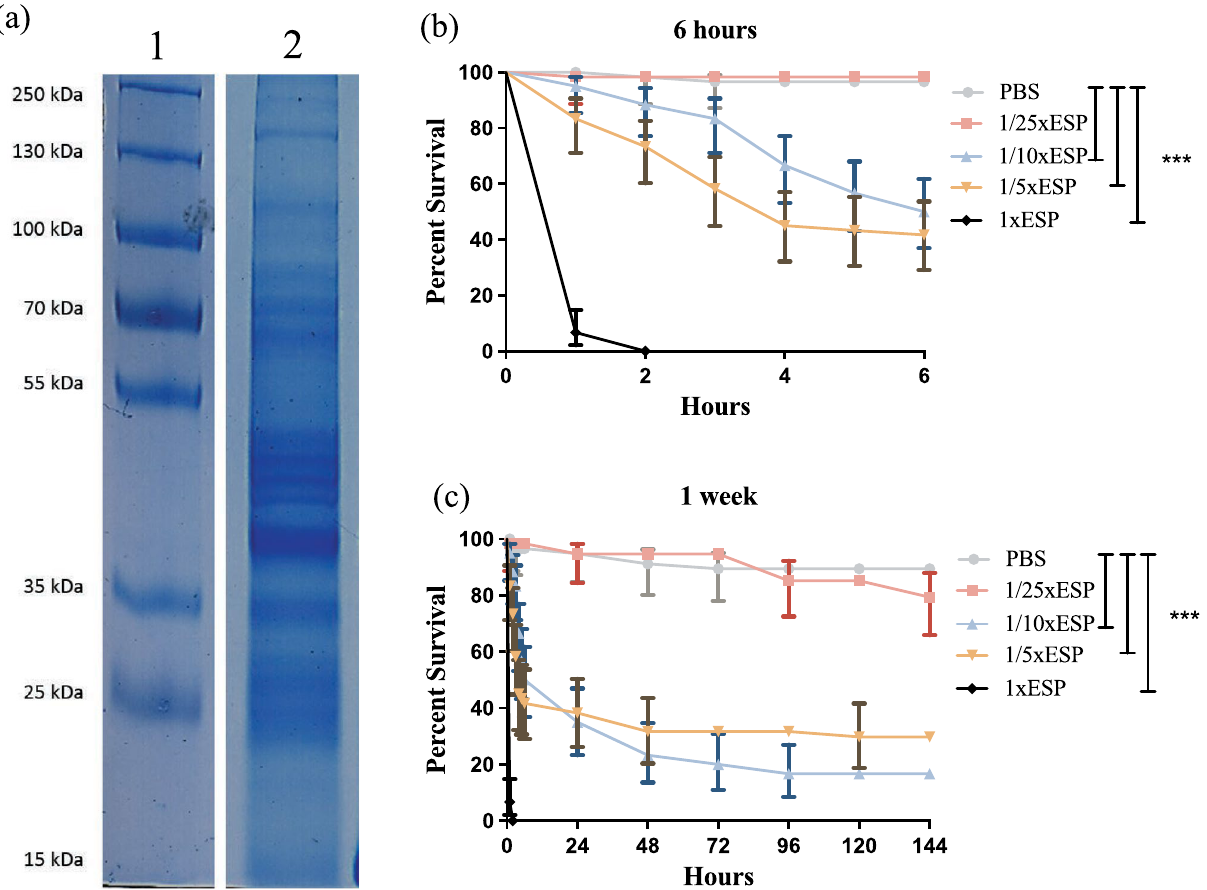
Figure 1. SDS-PAGE analysis of the Steinernema carpocapsae excreted/secreted products (ESPs) and survival of Drosophila melanogaster adult flies following injection with nematode ESPs. ( a ) Protein molecular weight marker (Plus Prestained Protein Ladder, 15 to 250 kDa, Thermo Scientific) (Lane 1) and ESPs of S. carpocapsae induced for 18 h in insect tissue homogenate (Lane 2). Cropped image; the original gel is presented in Supplementary Fig. 1. ( b ) Survival percentage of adult wild type Oregon-R flies within the first 6 h of injection with different concentrations of S. carpocapsae ESPs; 1xESP (4.25 μg/μl), 1/5xESP (0.85 μg/μl), 1/10xESP (0.43 μg/μl), or 1/25xESP (0.17 μg/μl) dilutions. Individuals injected with PBS were used as a control group. ( c ) Survival percentage of adult wild type Oregon-R flies over the course of 1 week (144 h) following injection with different concentrations of S. carpocapsae ESPs. Significant differences between survival curves were calculated using Log-rank (Mantel-Cox) Test, (*** P <